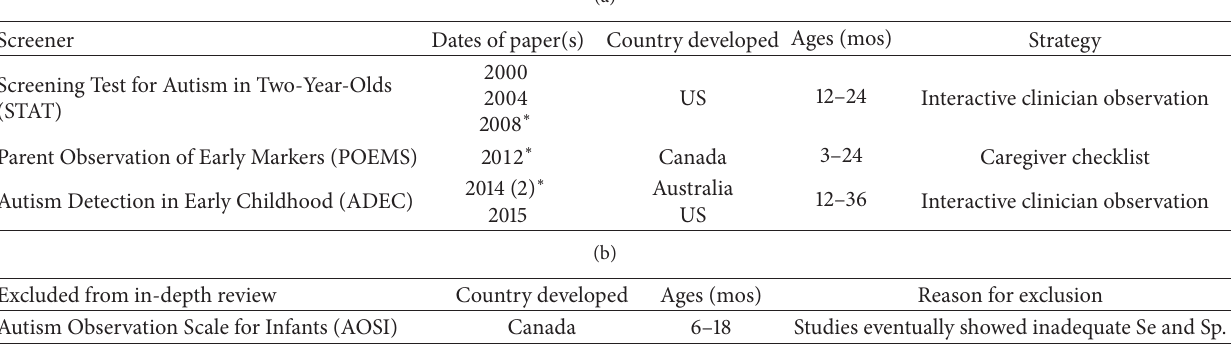
Table 4: Level 2 ASD screening instruments